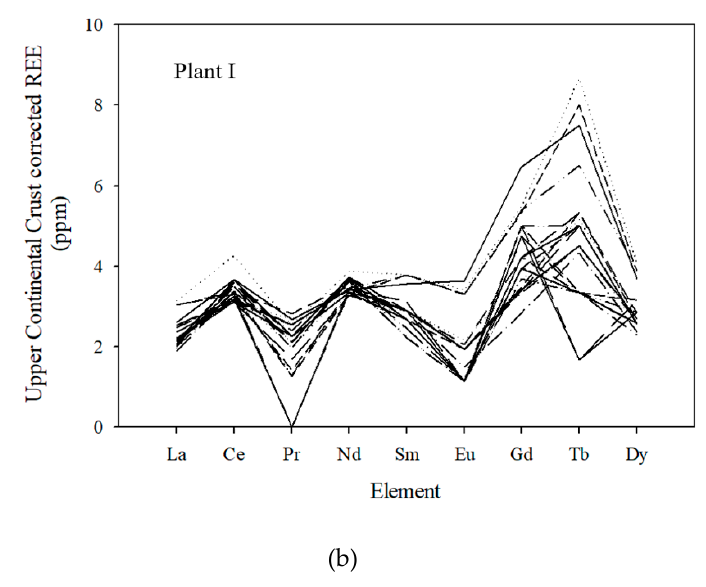
Figure 8. Spider plot of upper continental crust-corrected lanthanide distributions (correction factors after McLennan and Taylor, 1991) for ( a ) the Plant D <200-mesh product and ( b ) the Plant I <200-mesh product. Elements beyond Dy are not plotted due to uncertainty in the odd-number elements.